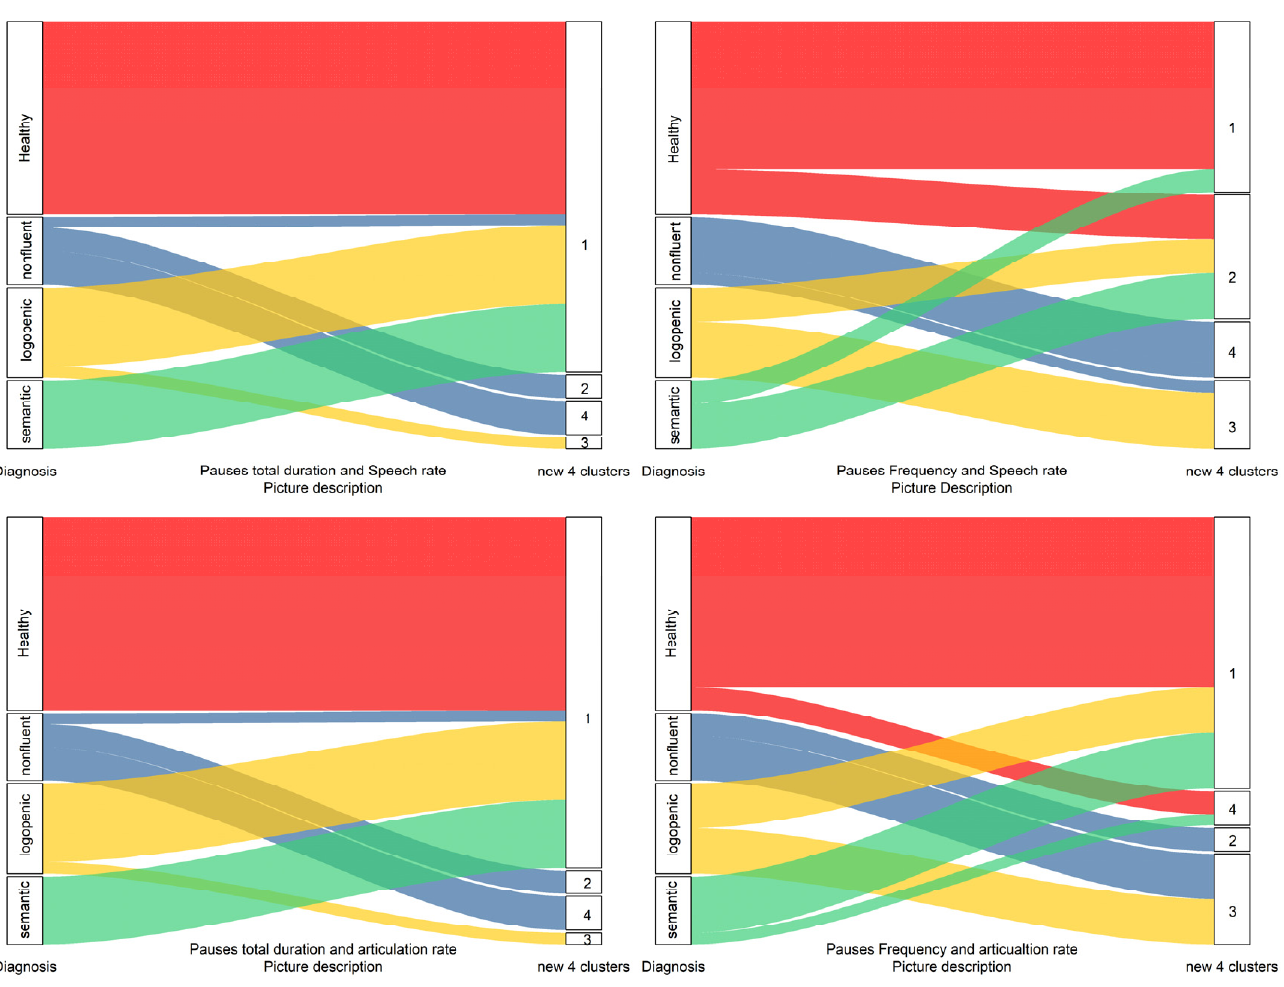
Figure 7. Re-classification of data for the picture description task. First node is the initial